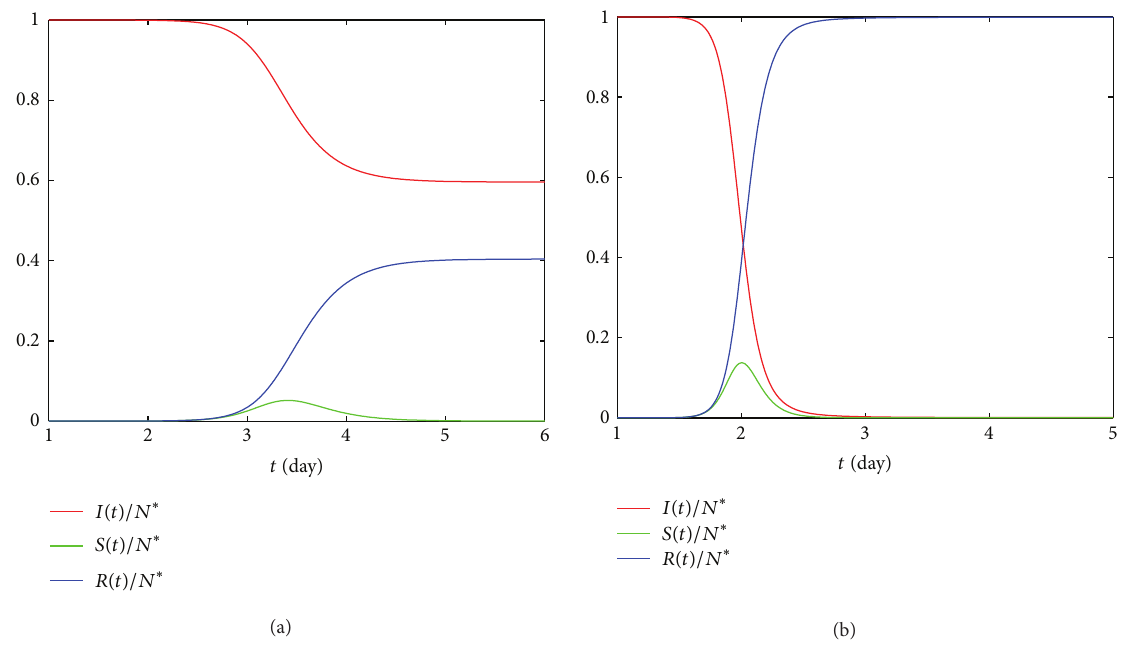
Figure 5: The number of each subclass in terms of time under different conditions, where 𝐼(0) = 5000000 , 𝑆(0) = 10 , 𝑅(0) = 0 , and 𝑊(0) = 0 . (a) 𝛽 = 10 , 𝛼 = 0 ; (b) 𝛽 = 10 , 𝛼 = 0.00001 .